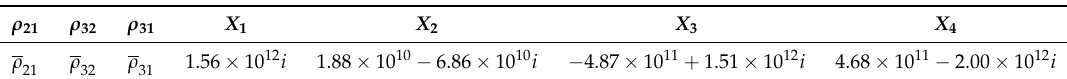
Table 2. The contribution of various effects into the formation of the stationary regime for signal SPP.